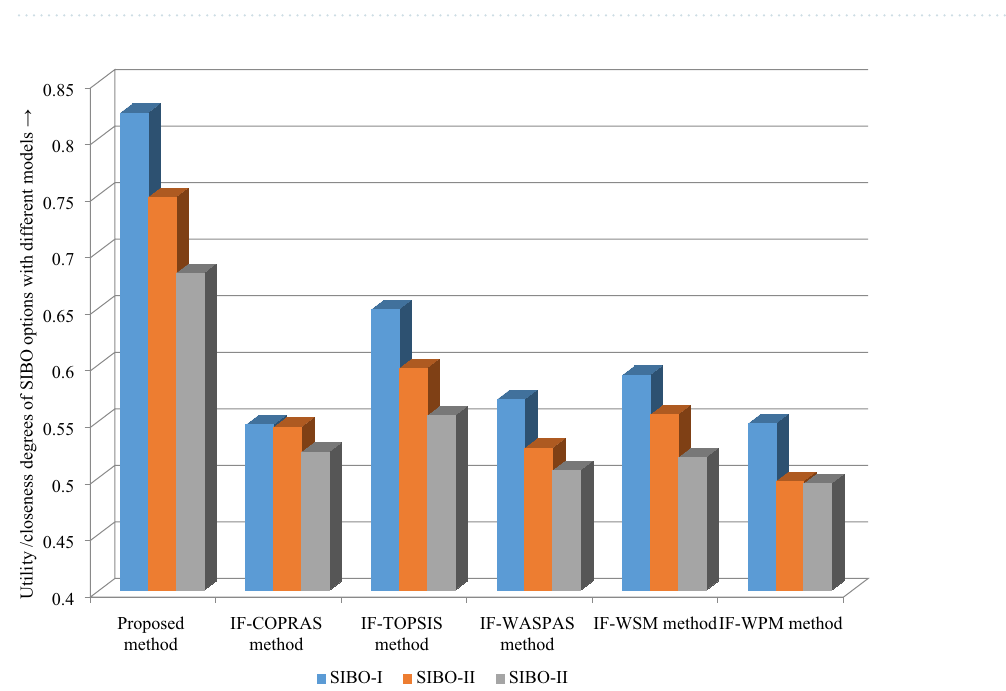
Figure 3. Assessment degree of options for prioritizing SIBO with different